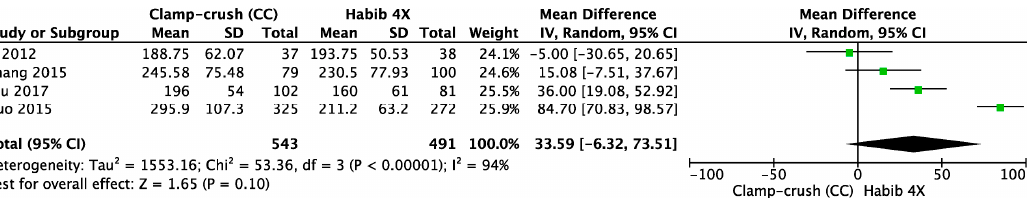
Figure 3. Forest plot representing the operative time (minutes) during liver resection comparing the control group (clamp-crush) with the study group (Habib™-4X). Squares’ size depicts effects while comparing the weight of the study in the meta-analysis. The diamond shows no favour towards any study group following the analysis. The 95 percent confidence interval is represented as horizontal bars.